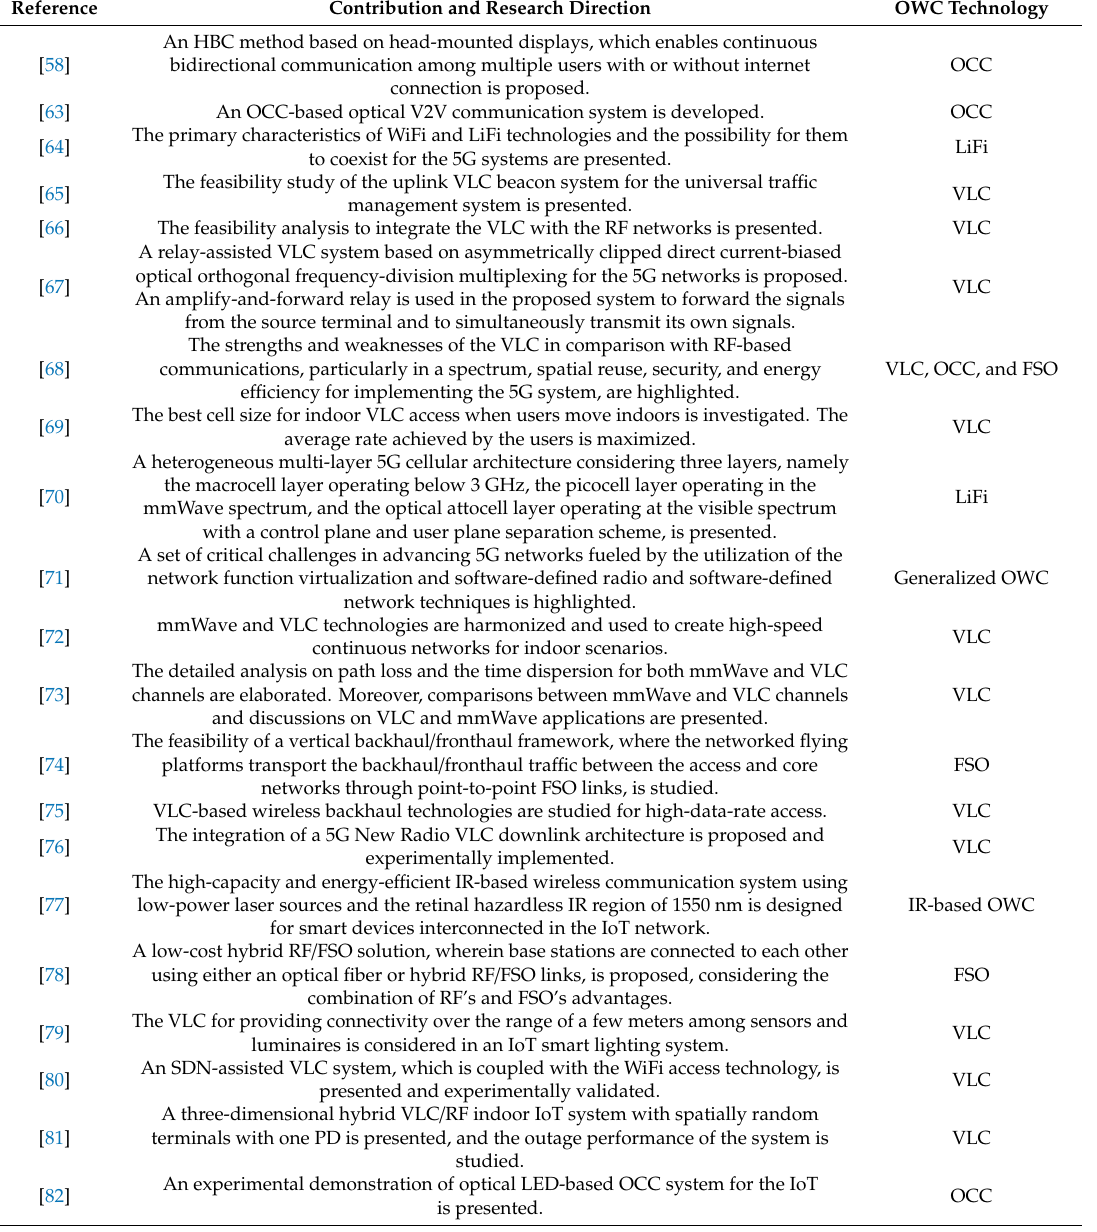
Table 5. Summary of the current research trends in the OWC based on the 5G and IoT systems.